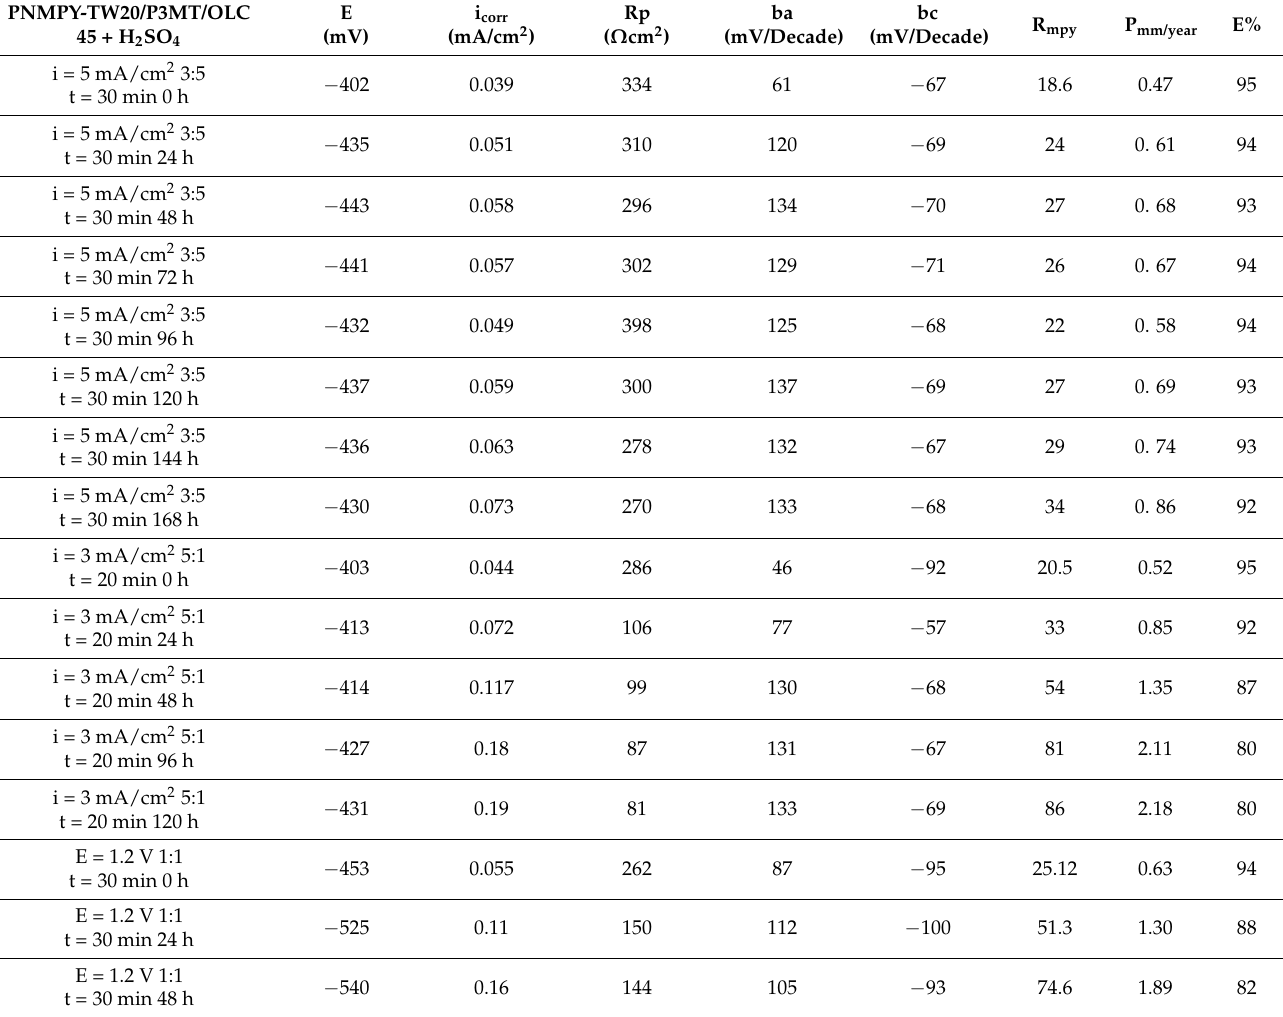
Table 5. Kinetic corrosion parameters of coated and uncoated OLC 45 sample in 0.5 M H 2 SO 4 solution at 25 ◦ C at varied immersion